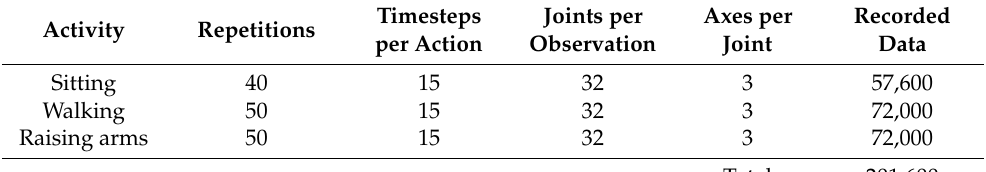
Table 2. Total data for training the RNN.